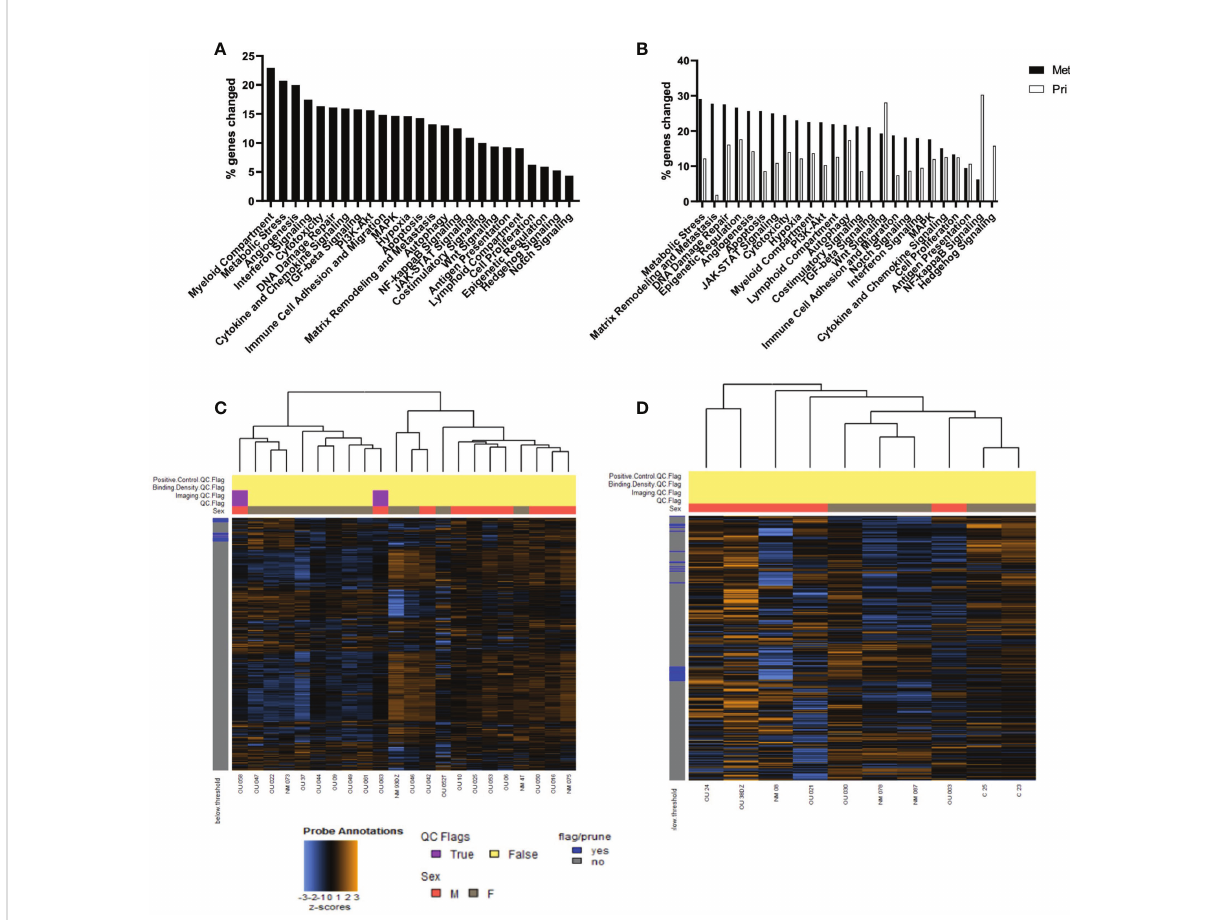
FIGURE 5 Gene expression differs in the TME of men and women in both primary and metastatic tumors. (A) The top percent of genes in pathways designated in annotated groups, as de fi ned by NanoString technologies, which were signi fi cantly different in expression between women as compared to men (p<0.05). (B) Top percent of genes in pathways differentially expressed between men and women from primary tumor compared to metastatic tumor (p<0.05). Heatmap for NanoString analysis of primary (C) and metastatic (D) CRC samples. Gene expression levels are illustrated with a Z score. Orange indicates high expression; blue indicates low